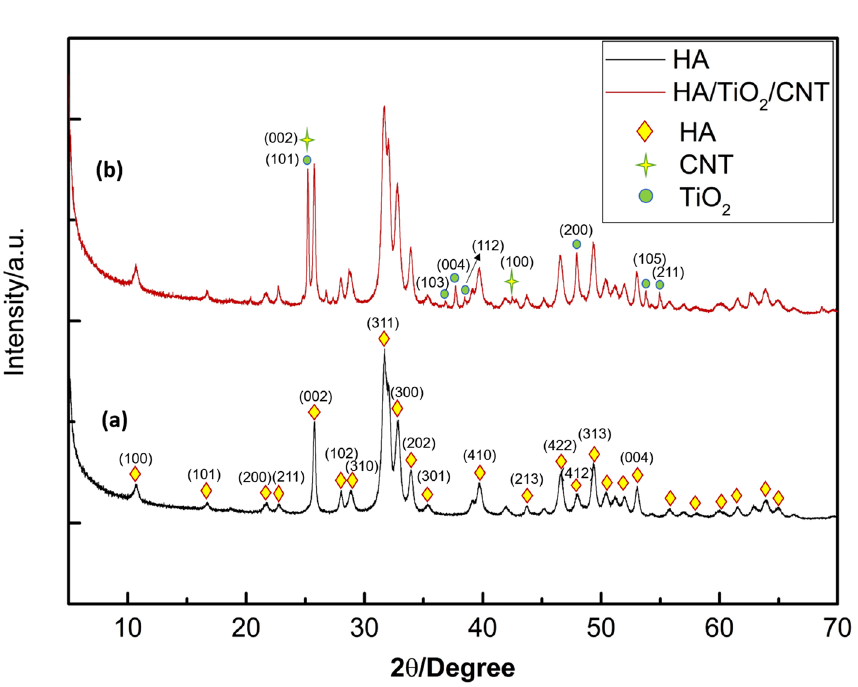
Figure 6. XRD spectra of the HA and S3.0